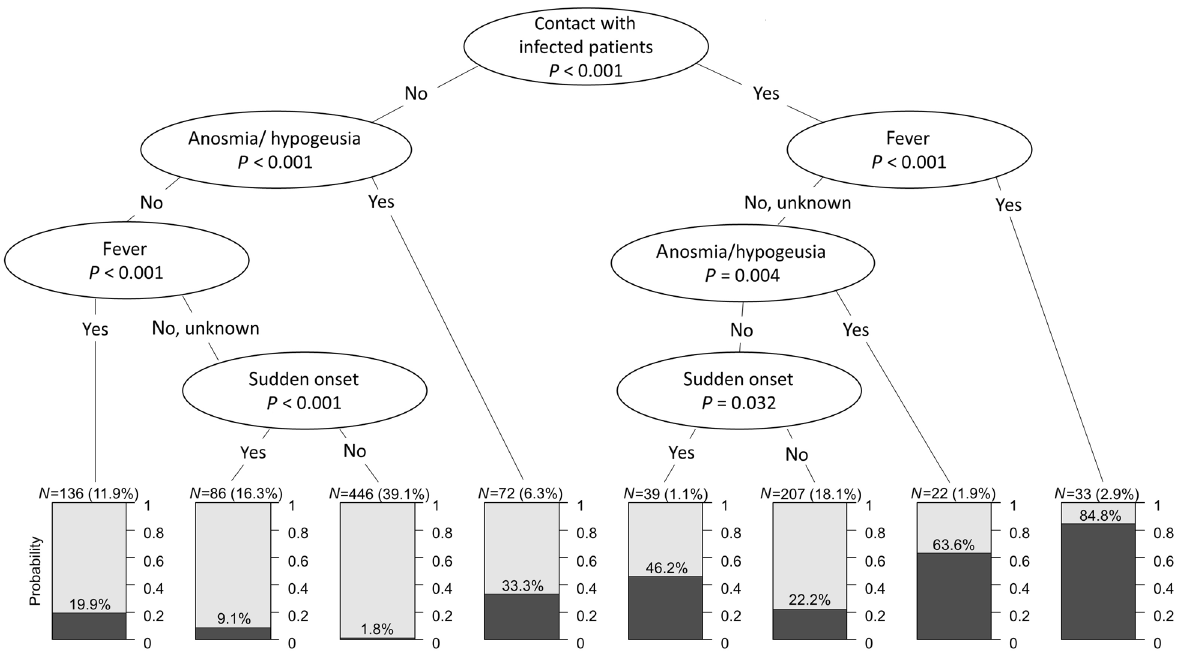
Fig. 3 Conditional inference decision tree for the identi fi cation of a SARS-CoV-2-positive PCR test result. All questionnaire items (see Table 1), including age and sex, were offered to the